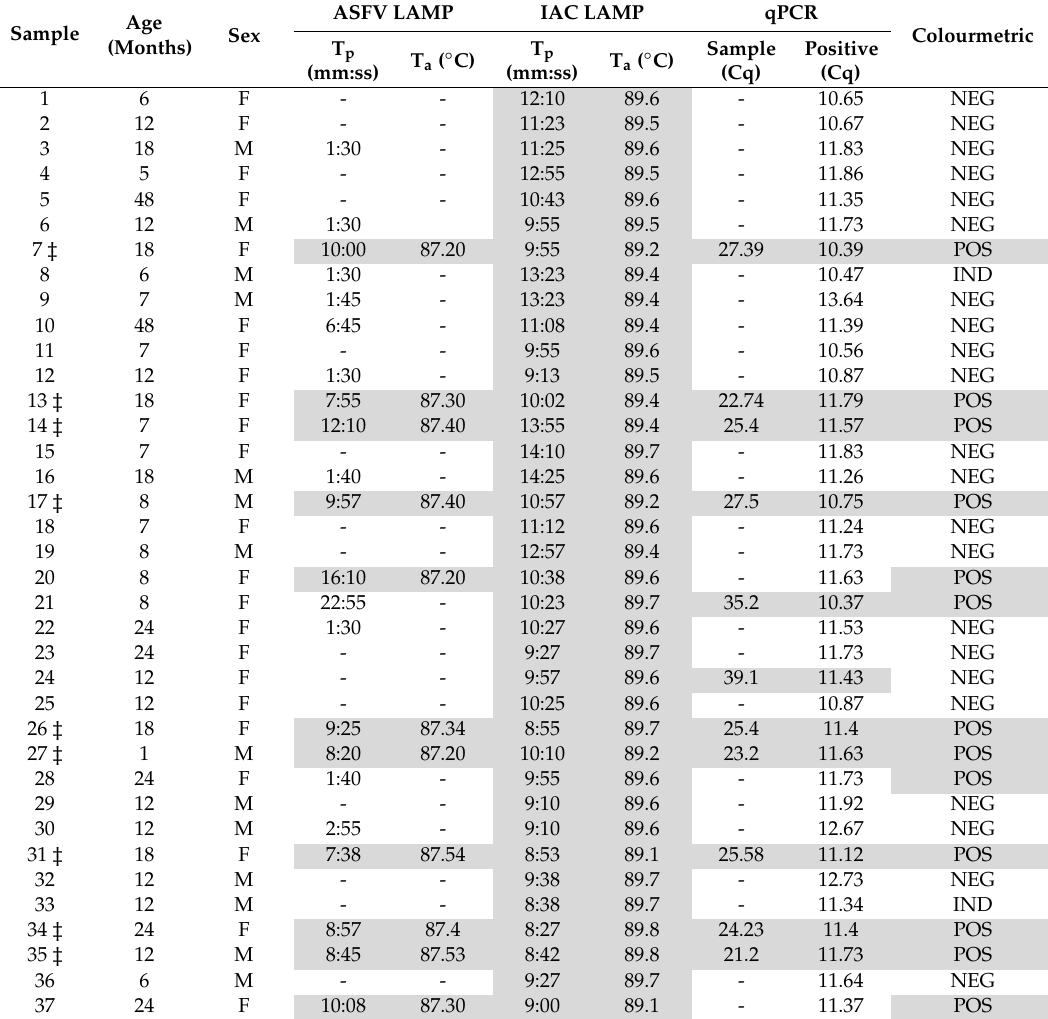
Table 5. Results of 37 serum samples from Baucau, Timor-Leste, tested with the LAMP, qPCR and colourmetric LAMP assay. Grey highlighting indicates a positive for that particular assay, a double dagger ( ‡ ) beside the sample number indicates a positive for all four assays. qPCR results are shown for the sample as well as the positive control. Colourmetric results are negative—pink colouration (NEG), positive—yellow colouration (POS) or indeterminant—orange colouration (IND).